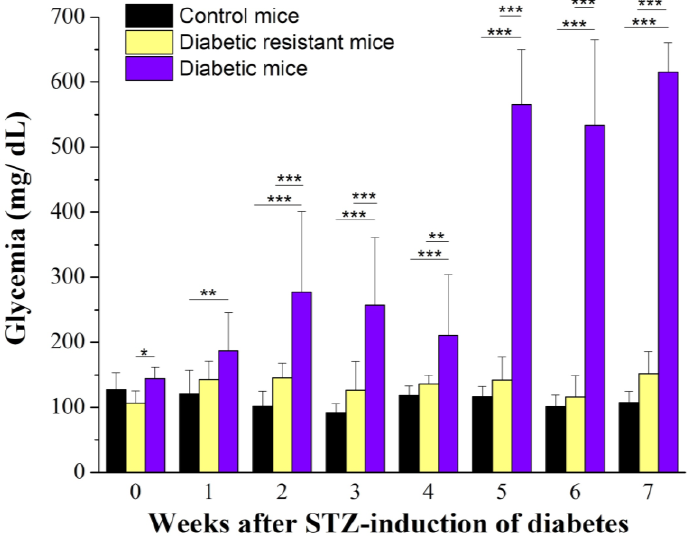
Figure 1. Blood glucose values (in mg / dL) were represented as mean ± SD for control, diabetic resistant, and diabetic mice. Statistical significance was indicated *** p < 0.001, ** p < 0.01, * p < 0.05. Only the diabetic group had an increase in glycemia (from 144.16 ± 17.29 mg / dL